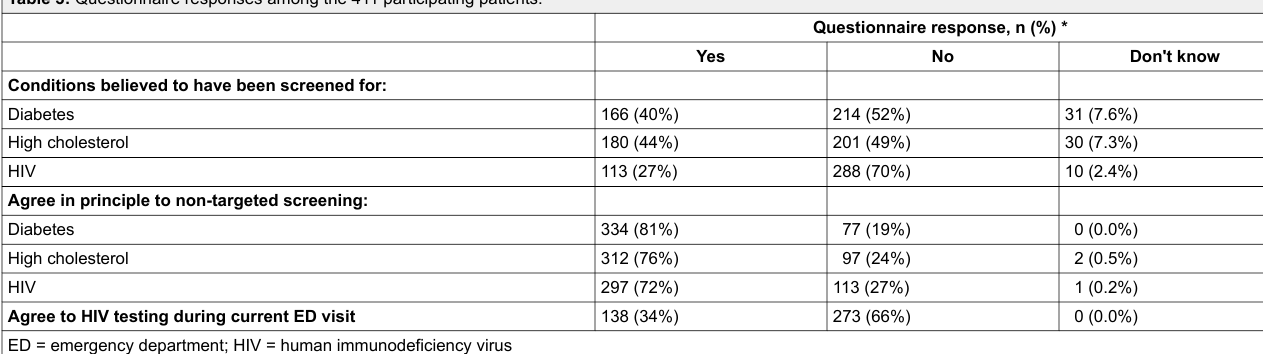
Table 3: Questionnaire responses among the 411 participating